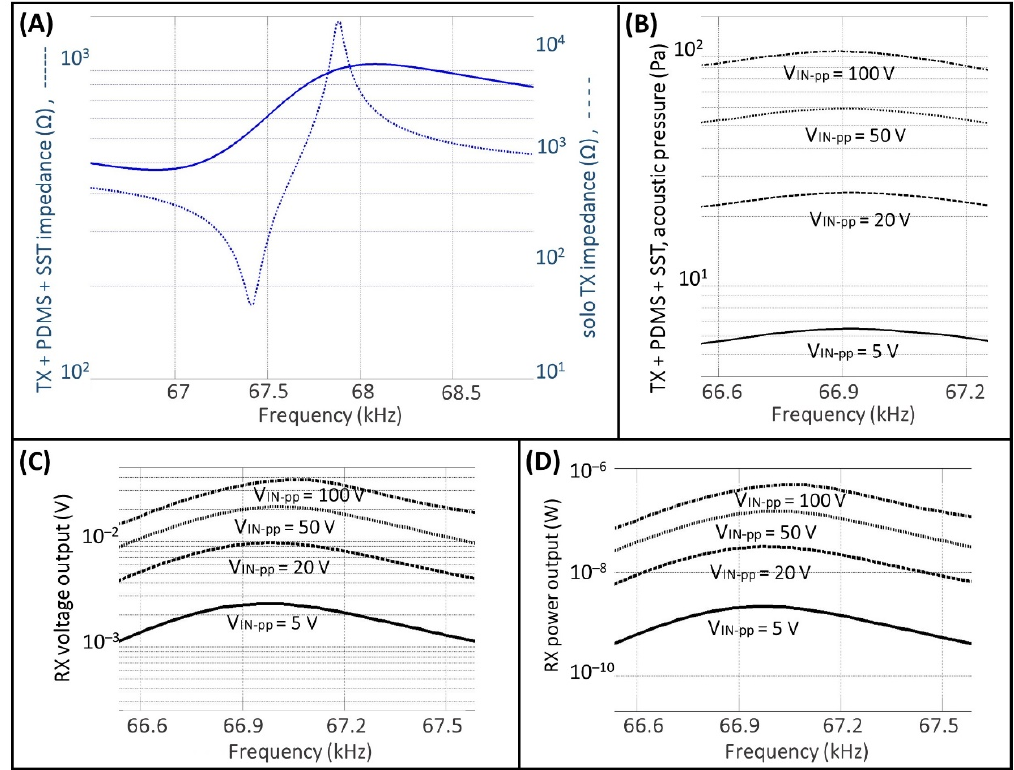
Figure 5. UPD system measurements. Comparison between the impedance value for the free TX and for the TX covered by the PDMS and the SST layer ( A ); acoustic pressure field ( B ); RX voltage output ( C ); RX power output ( D ).